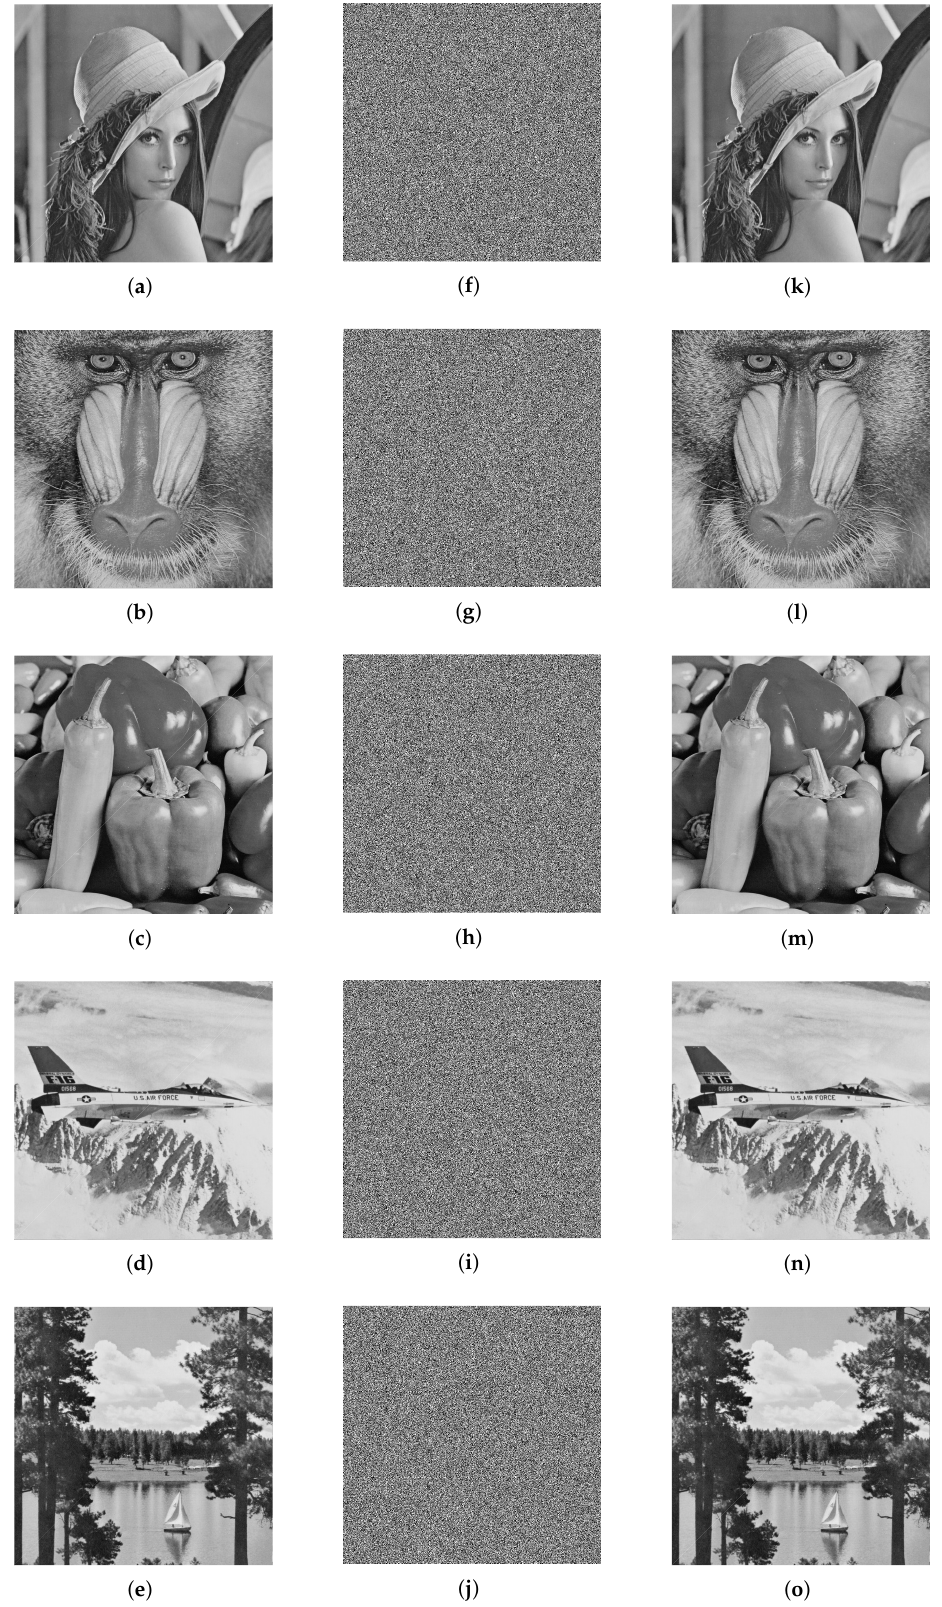
Figure 4. Encryption simulation. ( a )–( e ) are the plain images of ‘Lena’, ‘Baboon’, ‘Pepper’, ‘Airplane’ and ‘Lake’; ( f )–( j ) are the corresponding cipher images; ( k )–( o ) are the recovery images from decryption.